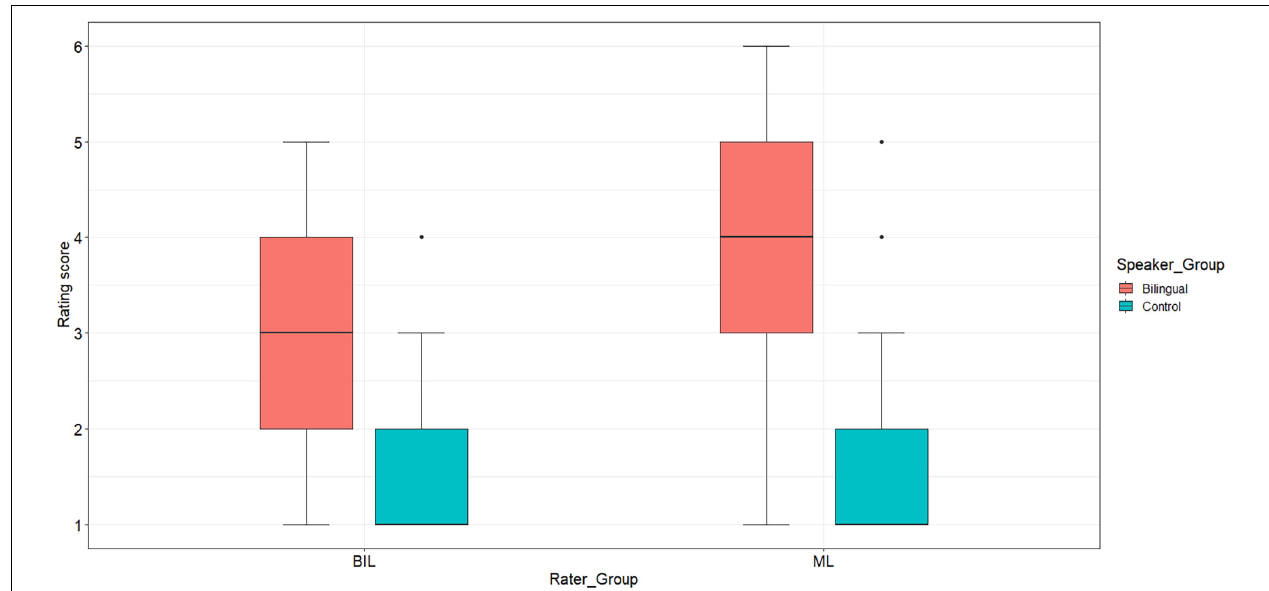
FIGURE 2 | Distribution of nativeness rating scores from 1 = certain of native speaker status to 6 = certain of non-native speaker status by rater group [Bilingual (BIL) raters vs. Monolingual (ML) raters].